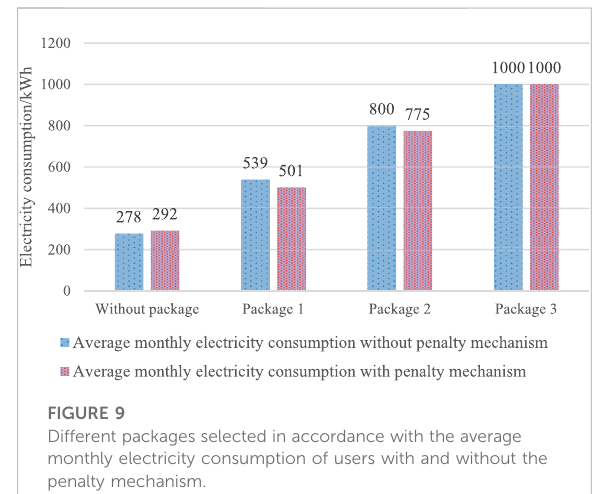
FIGURE 9 Different packages selected in accordance with the average monthly electricity consumption of users with and without the penalty